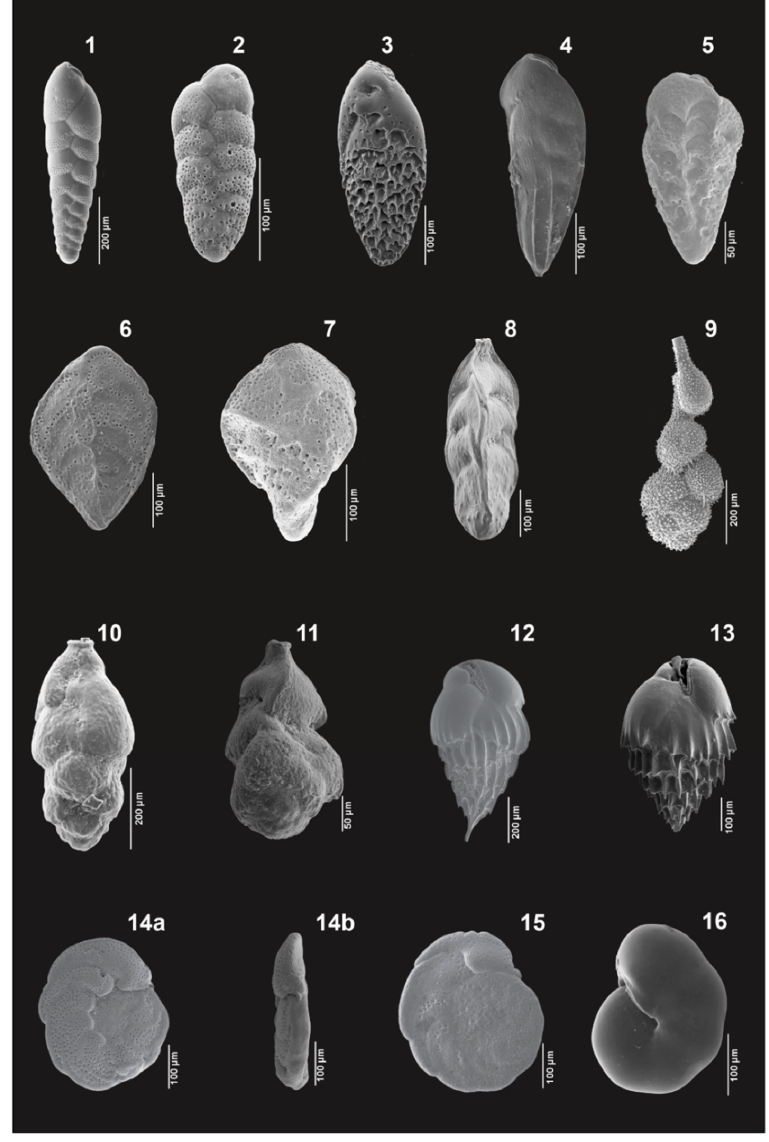
Figure A3. Plate III: 1— Bolivinellina translucens (Phleger & Parker, 1951), side view; 2— Bolivina vaughani Natland, 1938, side view; 3— Bolivina albatrossi Cushman, 1922, side view; 4— Bolivina fragilis Phleger & Parker, 1951, side view; 5— Bolivina pseudoplicata Heron-Allen & Earland, 1930, side view; 6— Bolivina goesii Cushman, 1922, side view; 7— Sigmavirgulina tortuosa (Brady, 1881), side view; 8— Trifarina bradyi Cushman, 1923, side view; 9— Uvigerina ampullacea Brady, 1884, side view; 10,11— Angulogerina occidentalis (Cushman, 1923), s.l., side views; 12,13— Bulimina striata d’Orbigny in Guérin-Méneville, 1832, side views; 14a,b,15— Planulina ariminensis d’Orbigny, 1826: 14a—umbilical view; 14b—apertural profile; 15—spiral view; 16— Pullenia aff. subcarinata (d’Orbigny, 1839), side view.